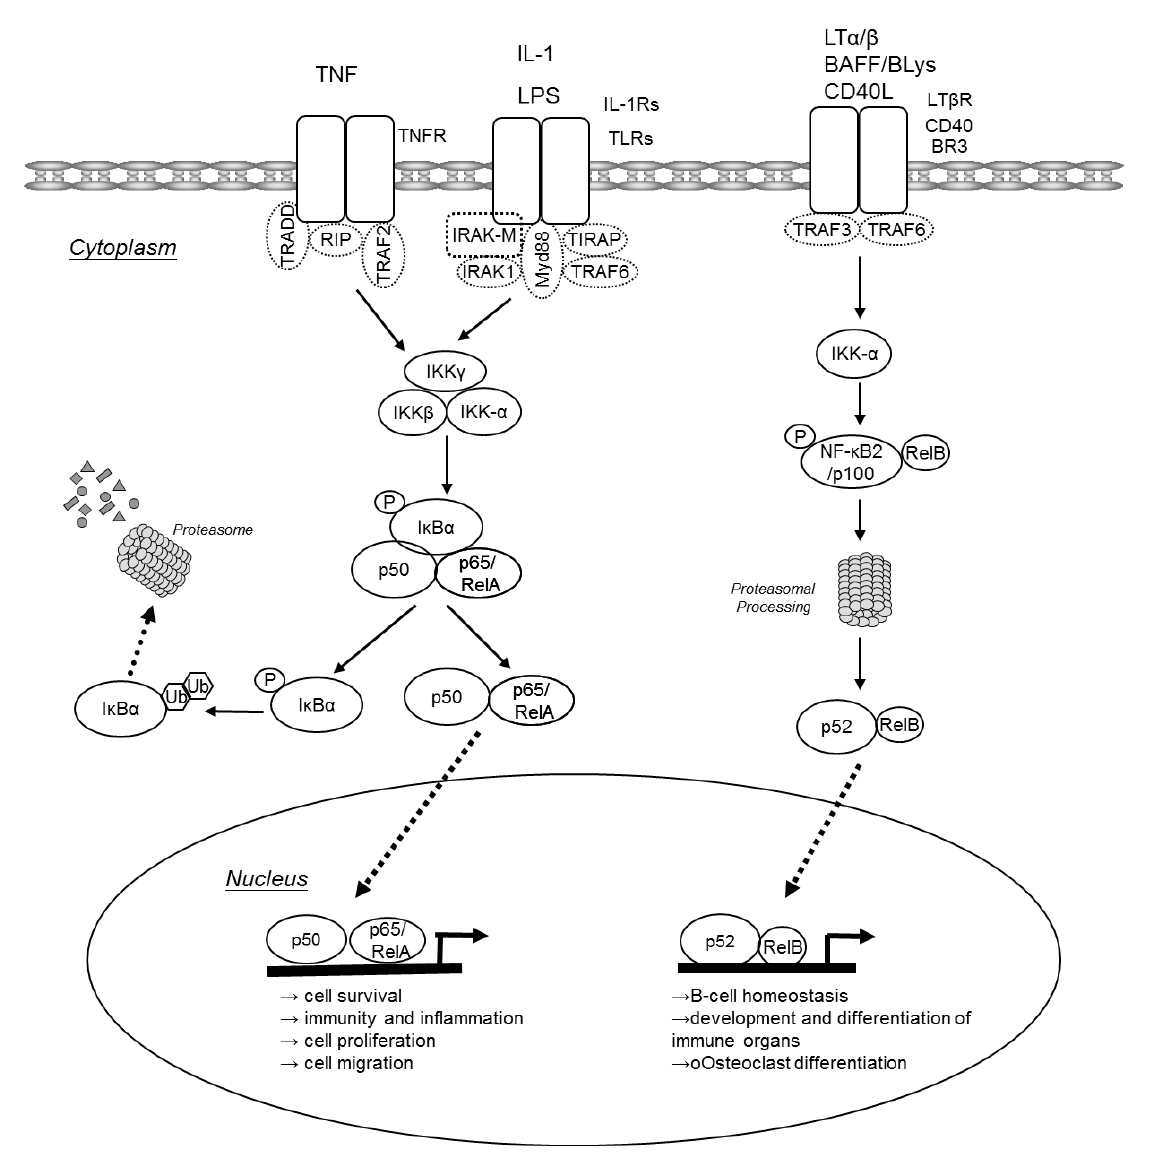
Figure 1. The two NF-κB activation pathways. The classical NF-κB pathway (left-hand side) results in translocation of primarily p50/p65 dimers in an IKK  /IKK  dependent manner. The alternative pathway for NF-κB (right-hand side) results in nuclear translocation of p52-RelB dimers and is strictly dependent on IKKα